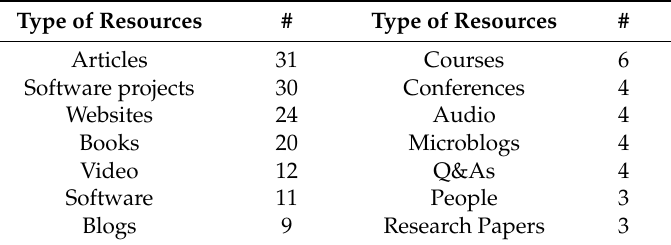
Table 2. Types of curated